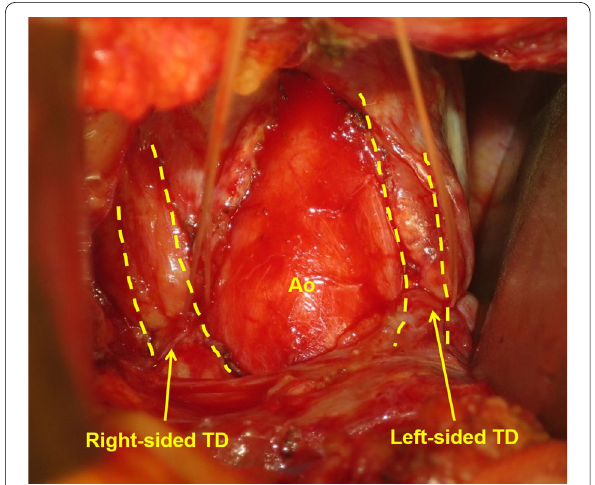
Fig. 2 Ligation of a left-sided thoracic duct. Mass ligation of the fat tissue on the left side of the aorta which contains the left-sided thoracic duct. TD thoracic duct, Ao aorta